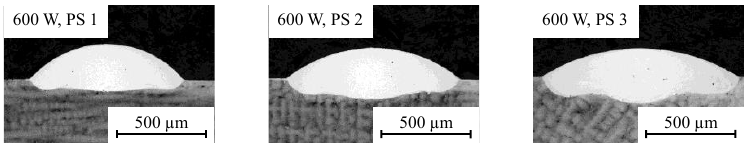
Figure 10. Weld seam geometry for varying pulse duration (PS 1, PS 2 and PS 3) and constant pulse peak power. Wire-feeding rate was 2 mm/s and pulse frequency 14 Hz.